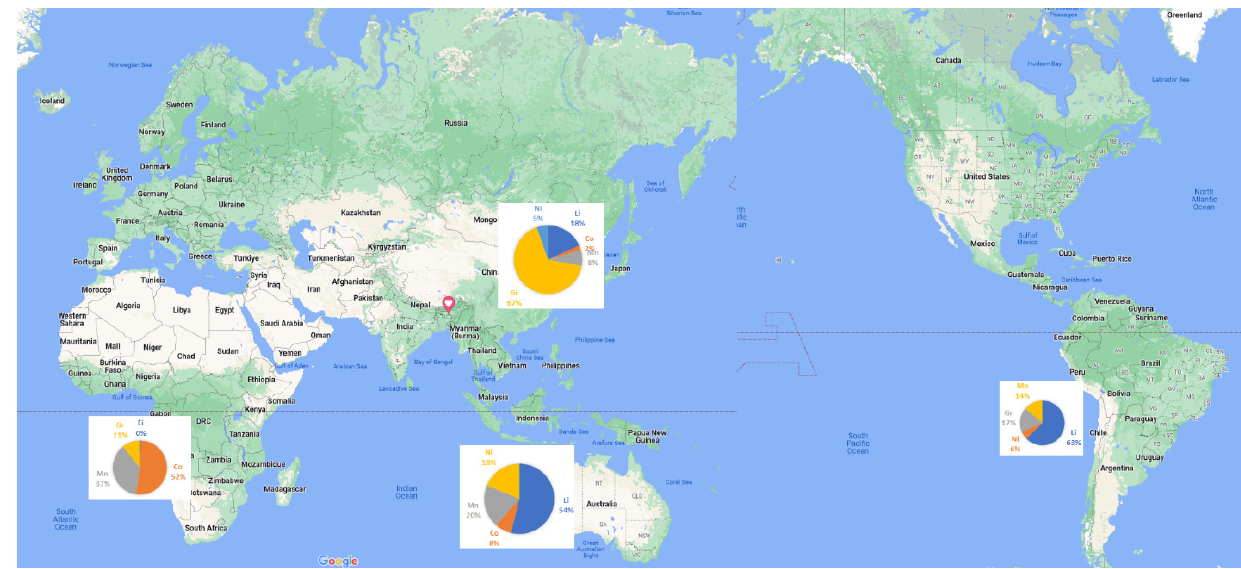
Figure 9. Geographical concentration of critical battery materials [4].